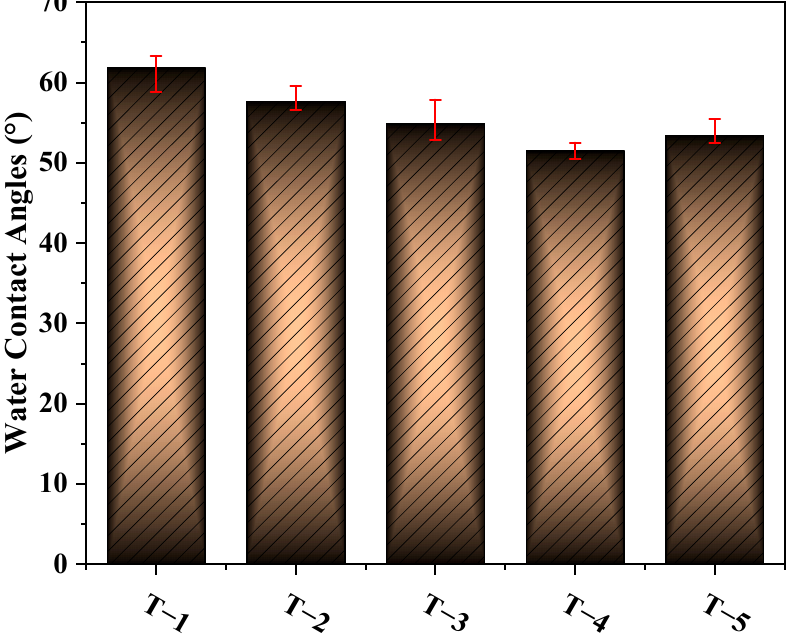
Figure 5. The water contact angles of the TFC-FO membranes with different amounts of MXene nano-sheets.